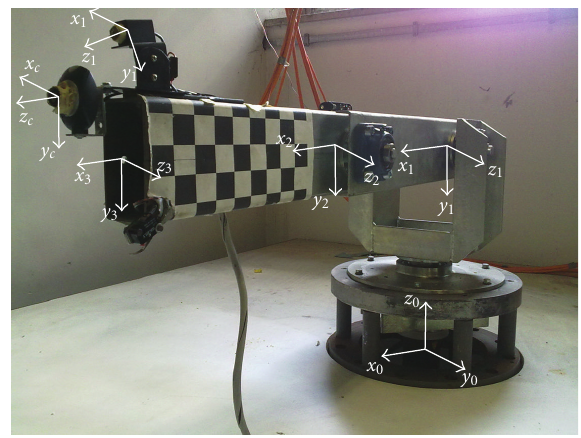
Figure 1: Robot arm and reference frame.